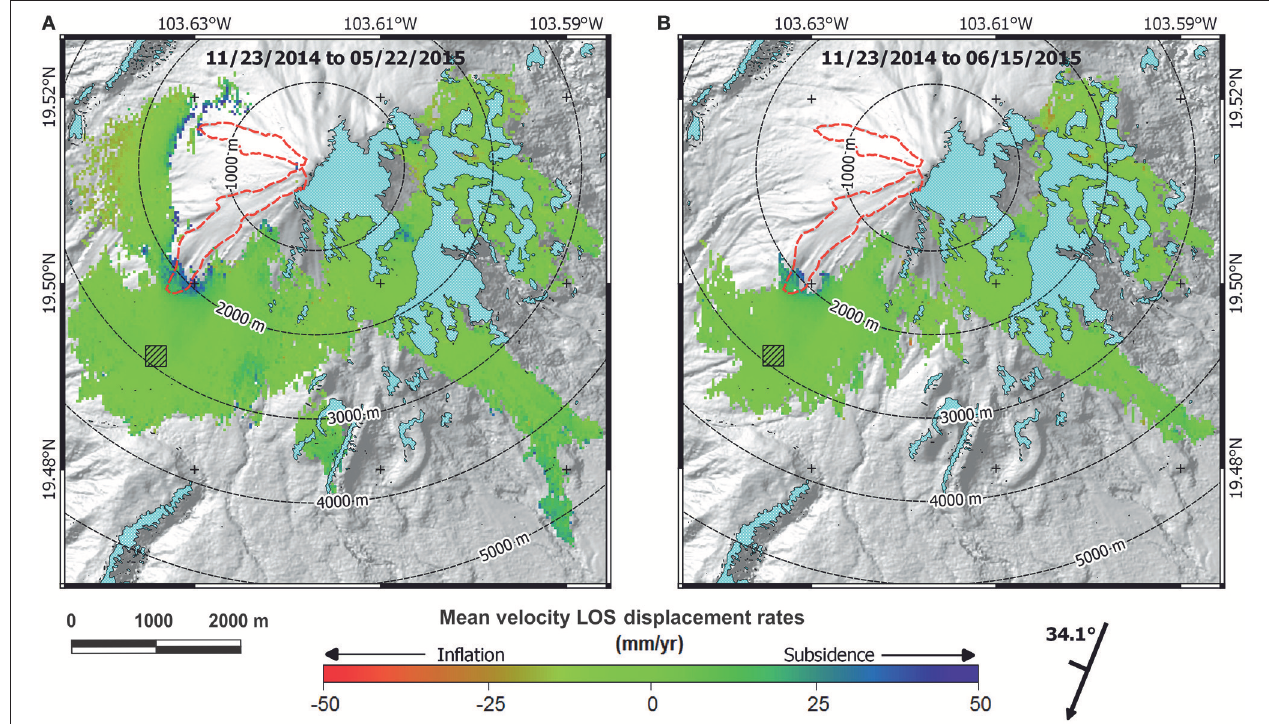
FIGURE 4 | Mean velocity in the Line of Sight (LOS) obtained by time series analysis of the descending track images acquired between (A) November 2014 and May 2015 (7 images used) and (B) November 2014 and June 2015 (8 images used). The velocity is shown only for pixels where the phase information remains coherent through time and having a RMS smaller than 0.4cm. Coherence is more reduced on interferograms calculated using the image acquired on 15 June 2015, which explains the difference in surface coverage on the two times series presented. The hatched square is the reference area where the displacement is set to zero. Cyan area is the surface affected by layover where SAR data cannot provide information due to the geometry of acquisition. Circles indicates the distance from the volcano summit. Dashed red lines correspond to the location of the lava flows causing the measured subsidences. The hillshade background was realized thanks to airborn LIDAR DEM acquired in 2004 by the Colima volcano